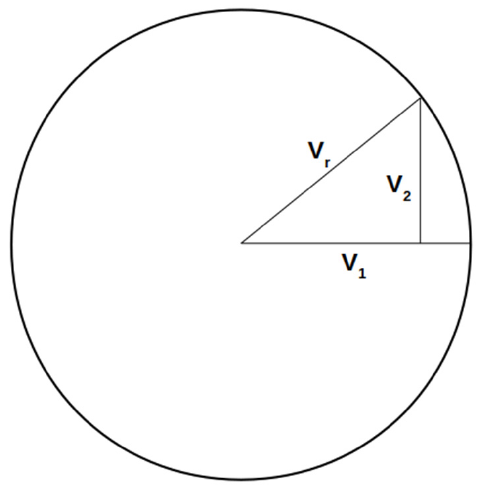
Figure 3. Relative velocity represented using equation of a circle.